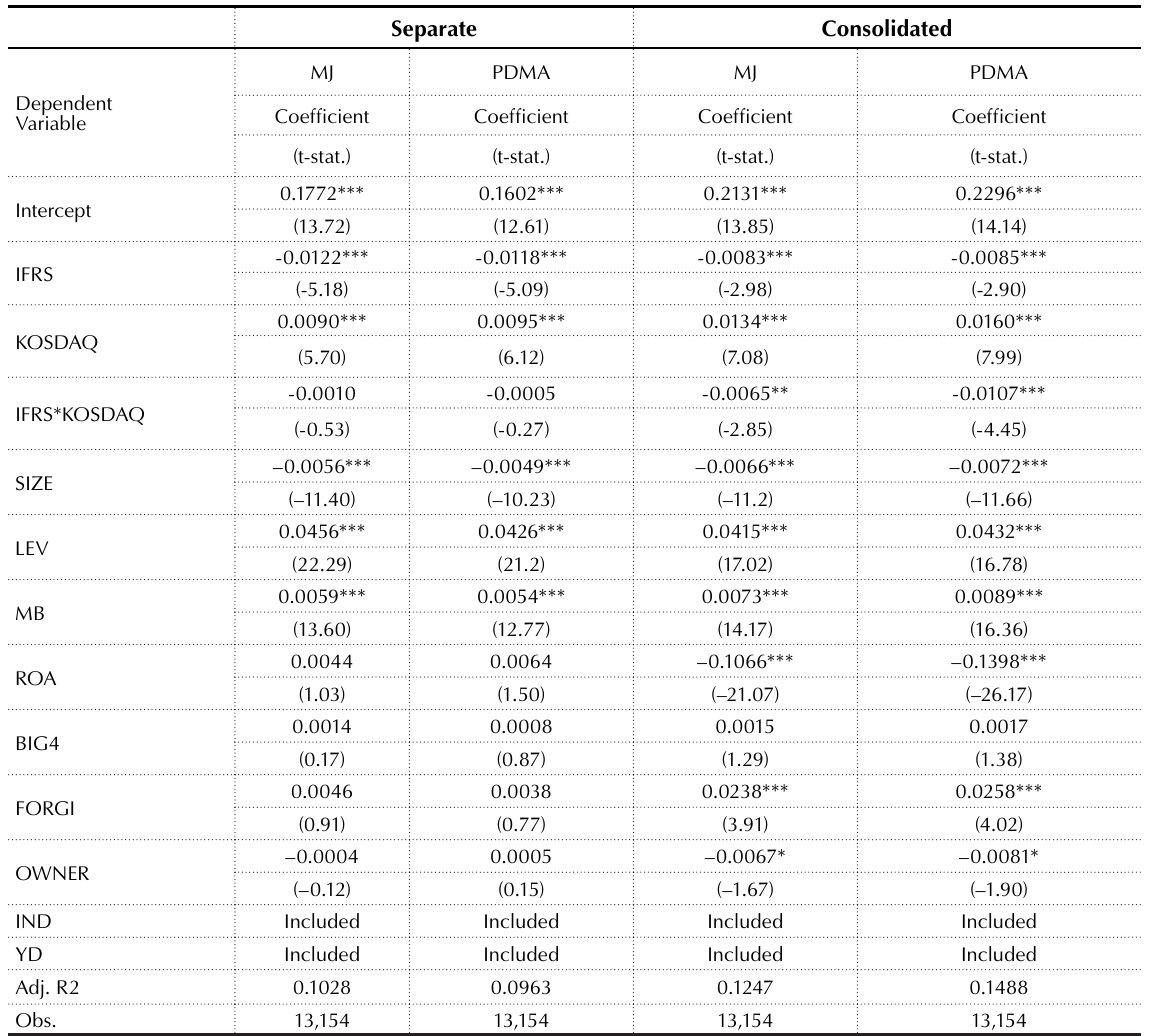
Table 4. Test results of hypothesis